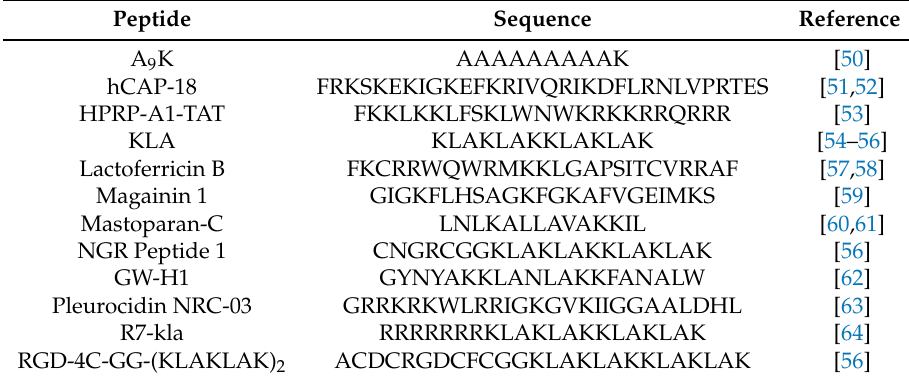
Table 6. Experimentally verified ACPs targeting mitochondria of cancer cells.